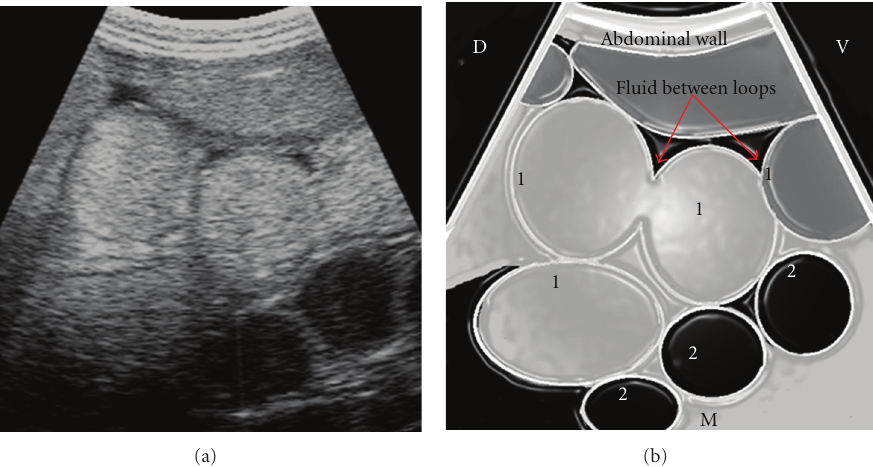
Figure 6: Ultrasonogram of dilated jejunal loops in jejunal intussusception imaged from mid-flank in cross-section. 1- Pre-intussusception dilated loops with echogenic content, 2- Post-intussusception loops with reduced diameter and anechogenic content, D: Dorsal, V: Ventral, M: